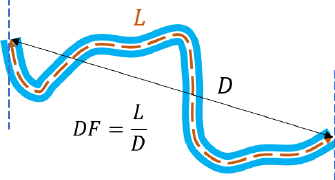
Table 3. Retinography labels according to subject, eye, and frame center.